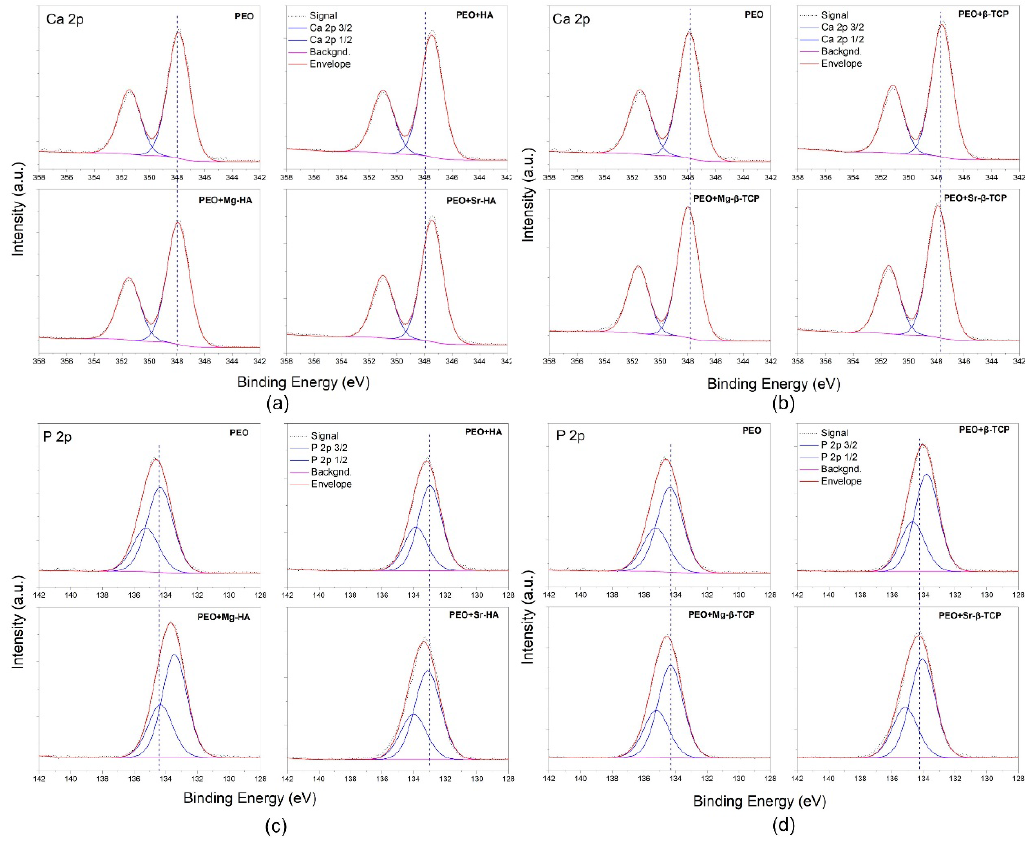
Figure 5. High-resolution XPS spectra of Ca 2 p ( a , b ) and P 2 p ( c , d ) core levels of composite CaP coatings.